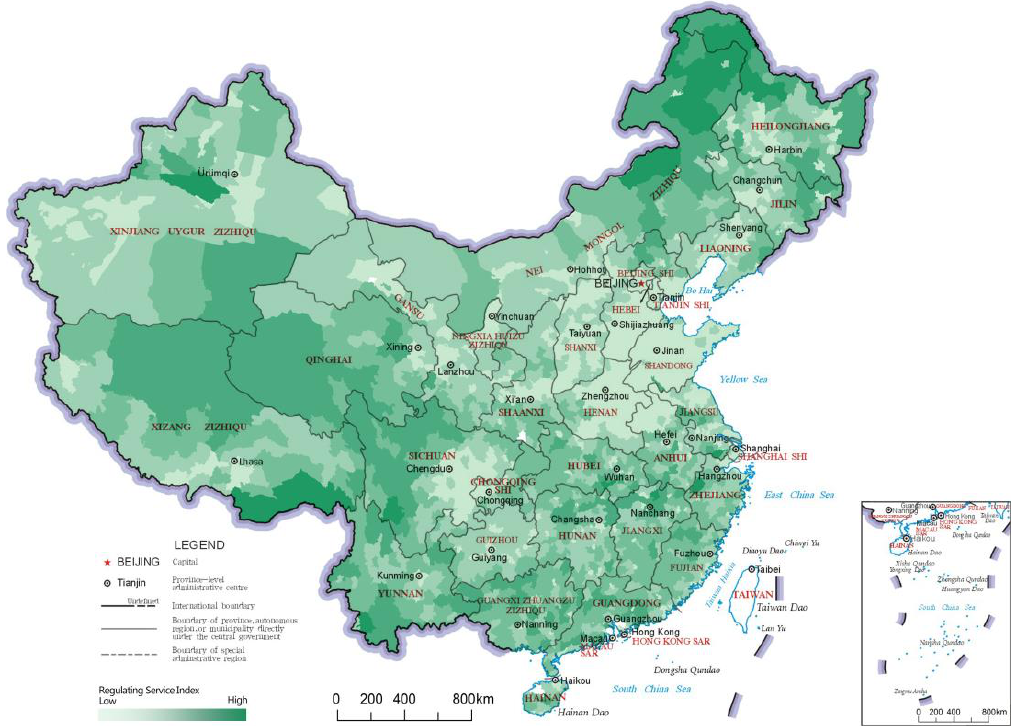
Figure 5. Distribution map of regulating service indices of the county-level regions in China.